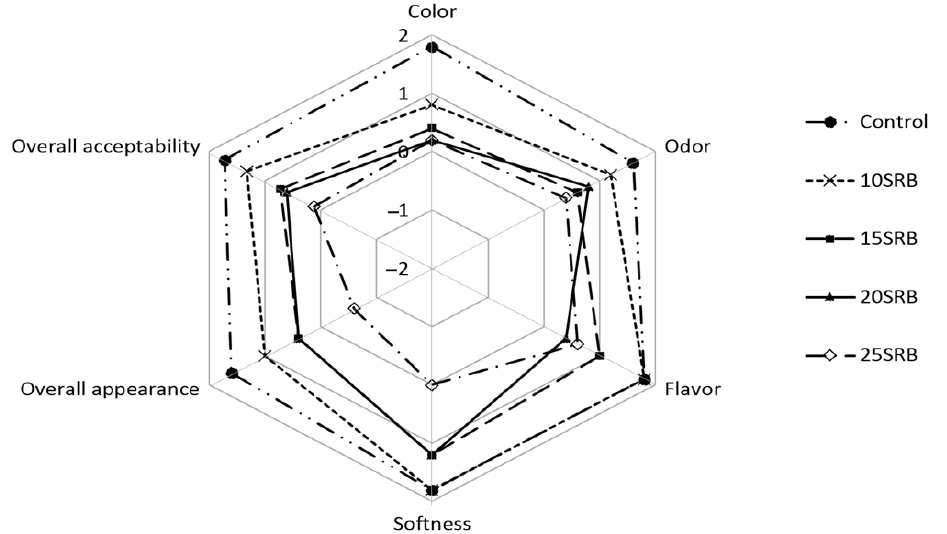
Figure 4. Sensory analysis of white wheat bread formulated with different levels of stabilized rice bran (SRB). Abbreviations: 10SRB, formulation with 10% of SRB; 15SRB, formulation with 15% of SRB; 20SRB, formulation with 20% of SRB; 25SRB, formulation with 25% of SRB.